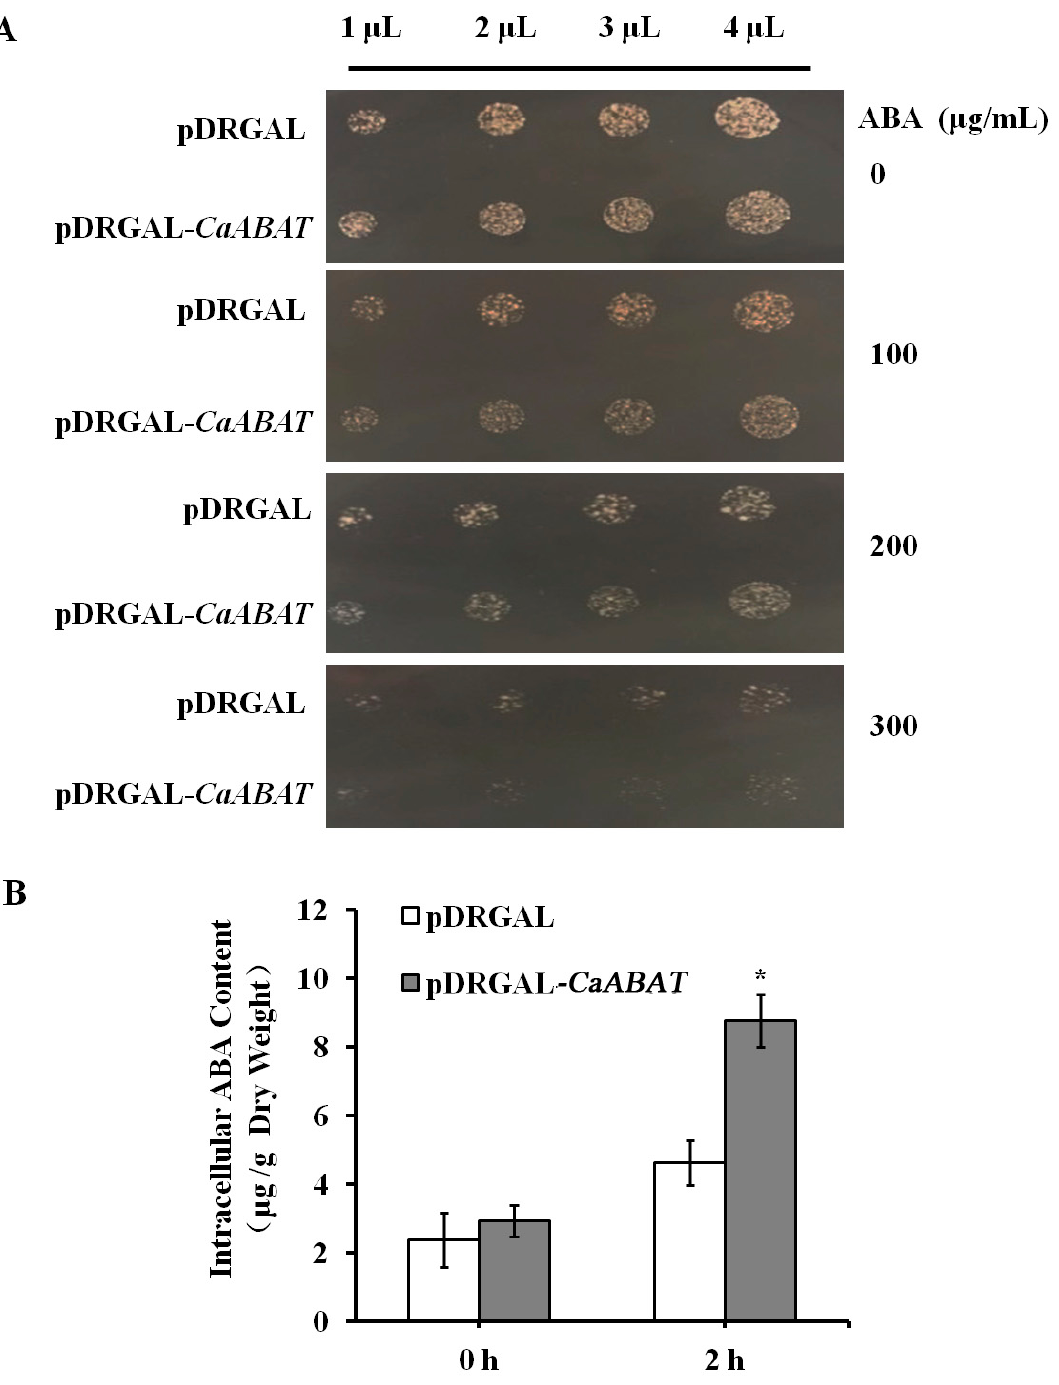
Figure 2. CaABAT is an ABA influx transporter. ( A ) The growth of CaABAT yeast transformants in a medium containing ABA. 1 to 4 μ L of yeast cultures (OD 600 = 0.1) were spotted on a 1/2 SG/-URA medium plate for 24 h at 28 °C. ( B ) ABA import activity of CaABAT. Yeast cells transformed with pDRGAL and pDRGAL- CaABAT were suspended in 1/2 SG/-URA medium supplemented with 100 μ M ABA. The error bars represent standard deviations from three biological replicates, and aster- isks indicate statistically significant differences compared with pDRGAL. * p < 0.05.